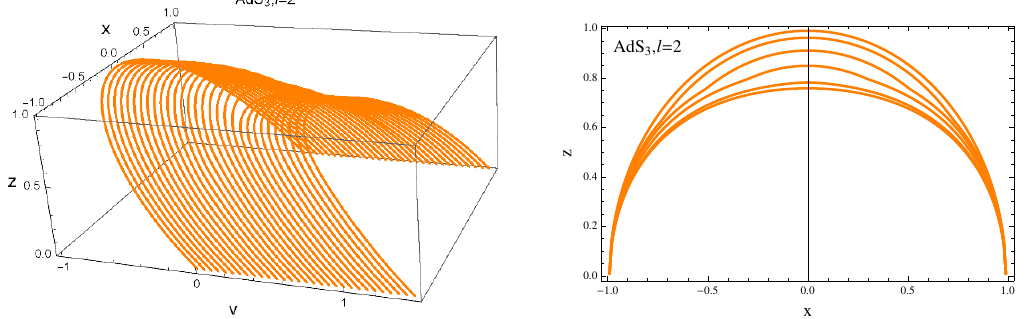
Figure 4 . The evolution of extremal surface (cid:13) A = (~ z ( x ) ; ~ v ( x )) for AdS 3 and l = 2. We (cid:12)x M = 1 and v 0 = 0 : 01 here. The left panel shows the evolution in ( x; v; z ). The right panel shows their projection on to the ( x; z ) plane. The extremal surface evolves from left to right in the left panel and from up to down in the right panel.